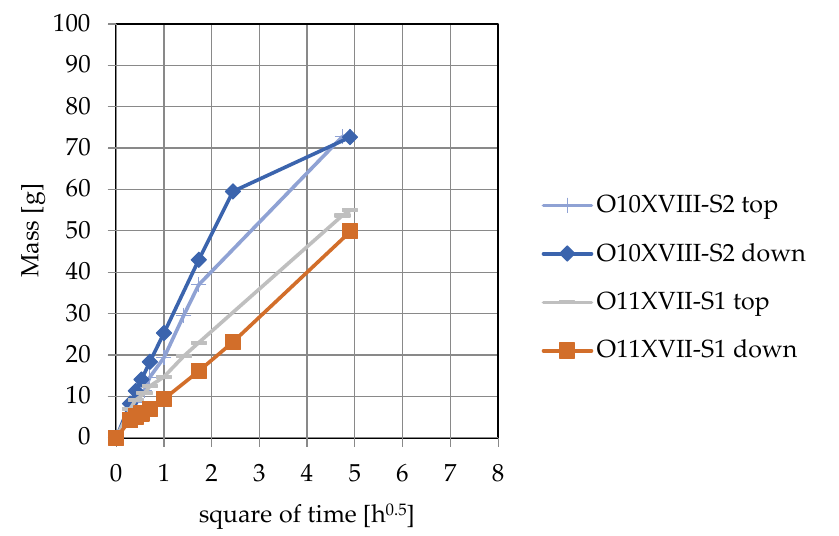
Figure 19. Mass of absorbed water in capillary rise test.